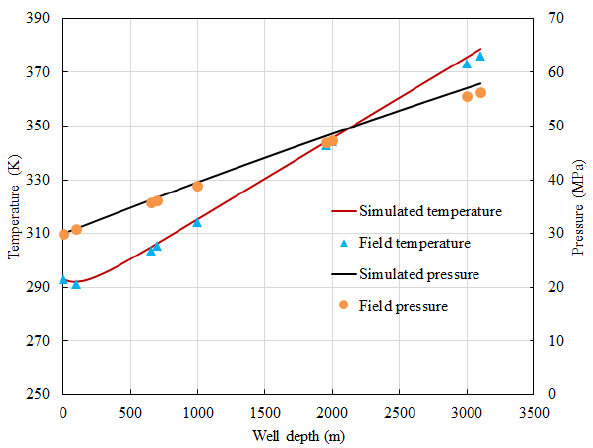
Figure 3. The measured and simulated data of Cao-8 in the second